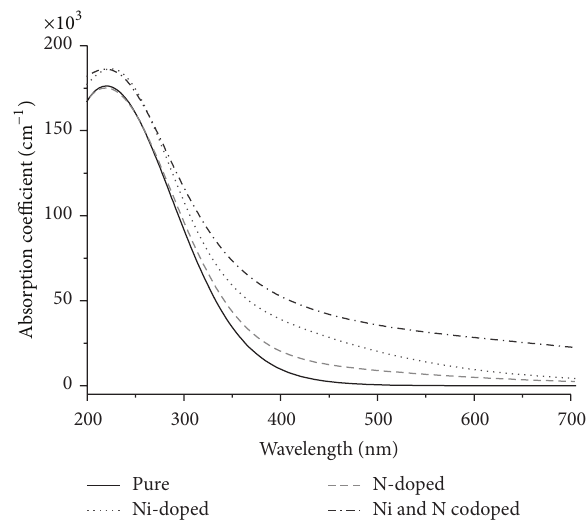
Figure 4: The calculated optical absorption curves for different kinds of rutile titanium dioxide